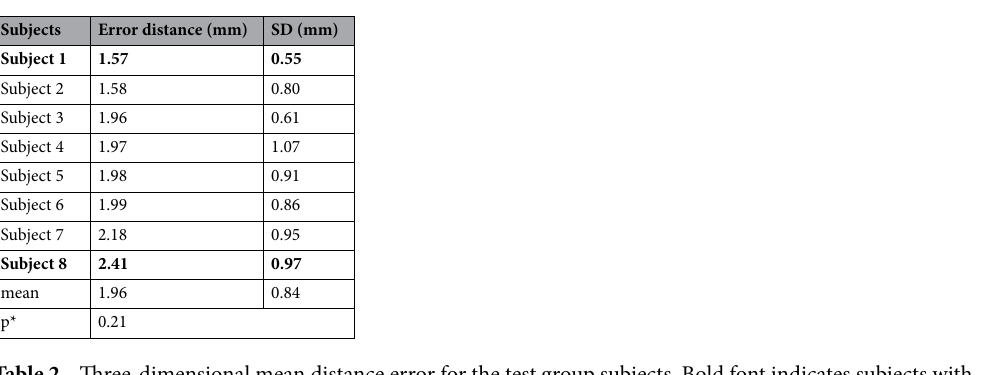
Table 2. Three-dimensional mean distance error for the test group subjects. Bold font indicates subjects with the best or worst error level, each of whom is depicted in Fig. 6 with individual landmarks. *Kruskal–Wallis